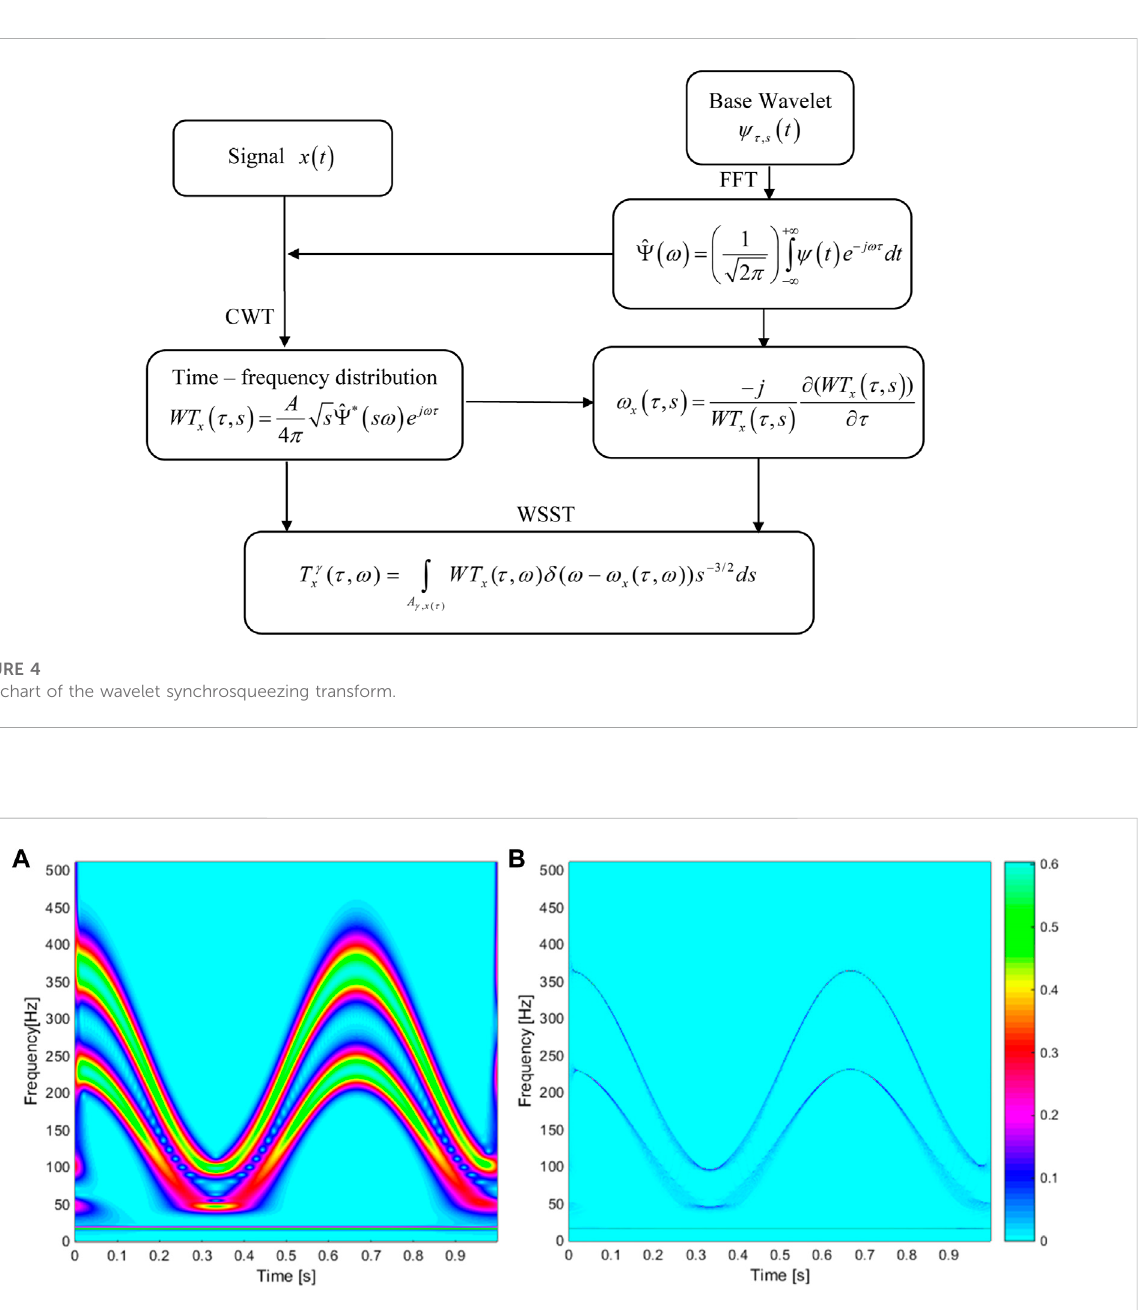
FIGURE 5 Comparison of the frequency resolution: (A) CWT and (B) WSST (Thakur et al.,